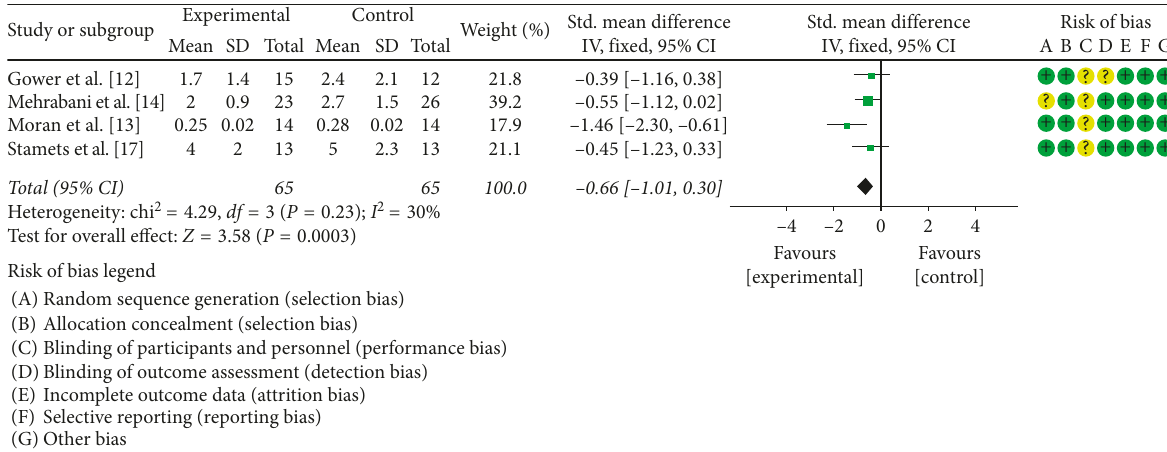
Figure 4: Meta-analysis of the effect of LCD on HOMA-IR in PCOS